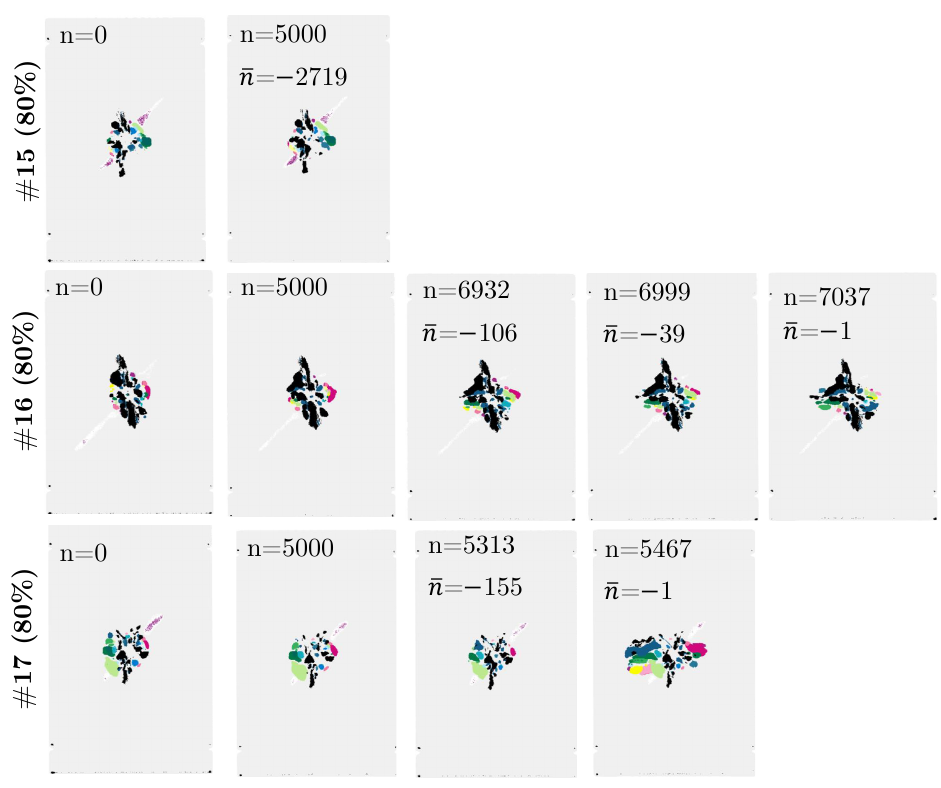
Figure A1. Observation of the delamination growth in the ultrasonic D-scan of selected specimens on the load levels 90% and 80%.